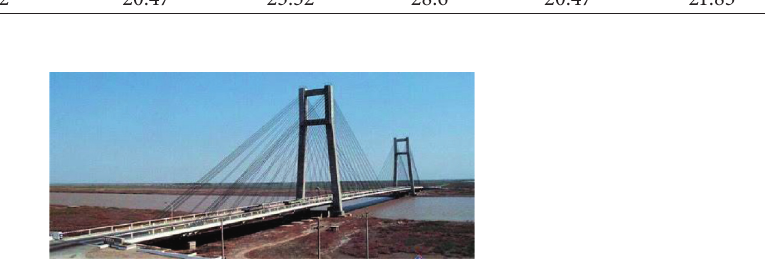
Table 4: Damage percentage in the BHM benchmark structure under different damage patterns. Damage pattern